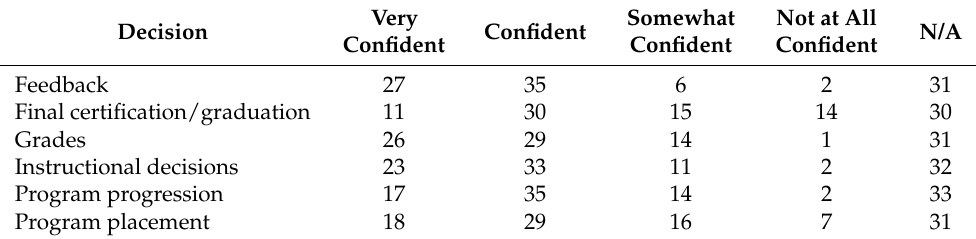
Table 7. Confidence in decision-making by